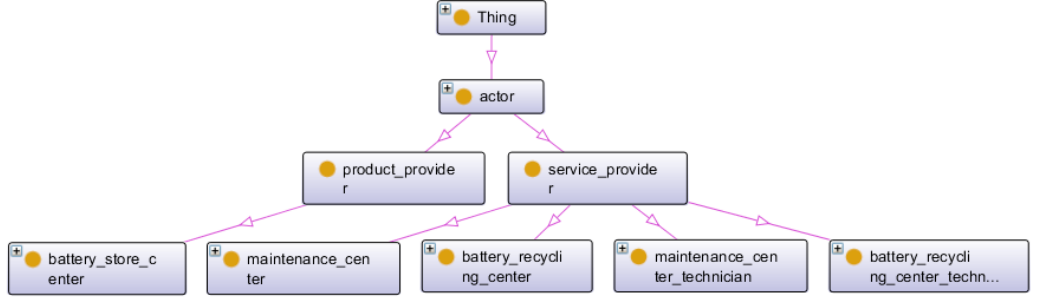
Figure 10. Overview of the actor environment.